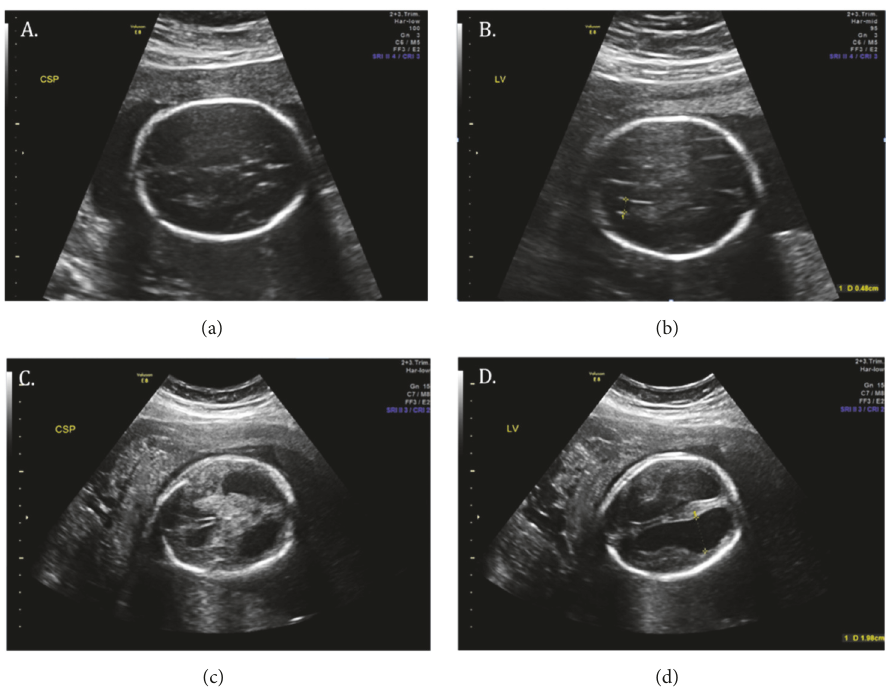
Figure 1: Normal brain anatomy seen at 23 weeks gestation (a, b) and massive ventriculomegaly and distortion seen at 26 weeks gestation (c,